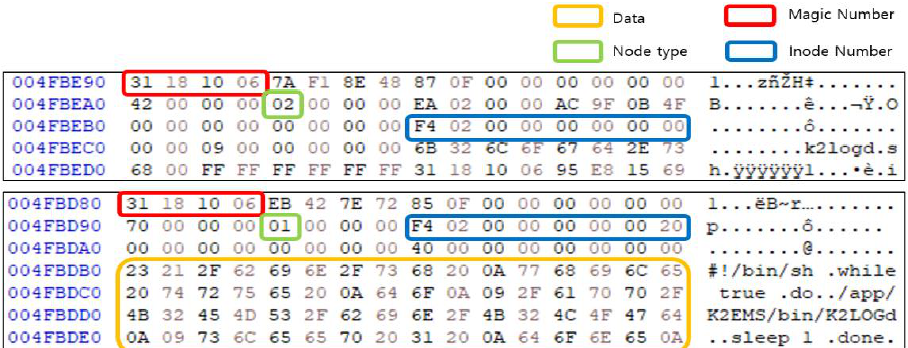
Figure 21. UBIFS directory of entry ( top )/data node ( bottom ).